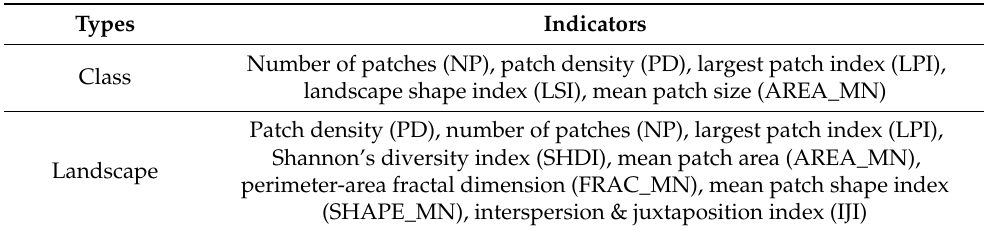
Table 3. Selected land use pattern indicators.